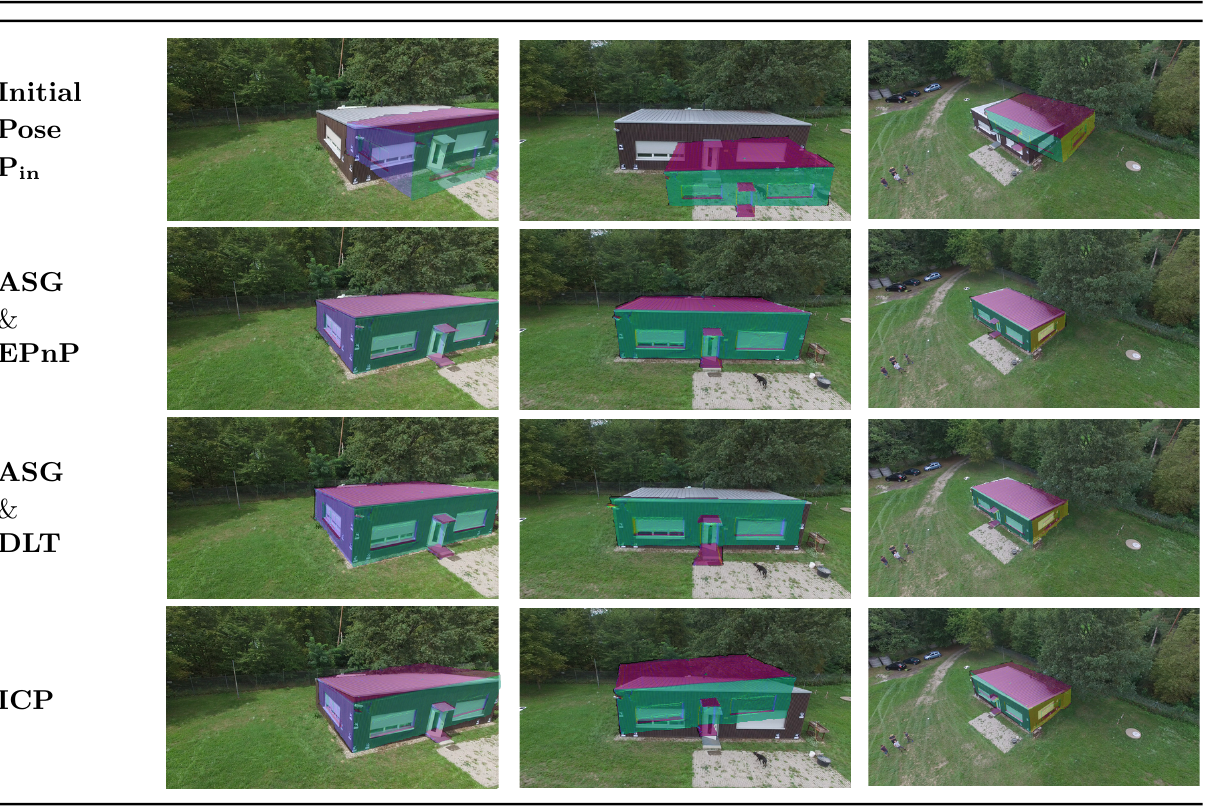
Figure 6. Qualitative results showing the input image together with a projection of the input model given the corresponding camera pose. The input model of the building structure is projected in transparent colors, which encode the normal vectors of the model surfaces. In the first row, the input model is projected given the initial camera pose. These images clearly show the error in the camera pose with which our algorithm is initialized. The images in the second and third rows depict the results of our co-registration algorithm for known and unknown camera intrinsics. The fourth row shows the results of the ICP algorithm. The results indicate that, in most cases, our algorithm achieves a good alignment between the input model and the input image.